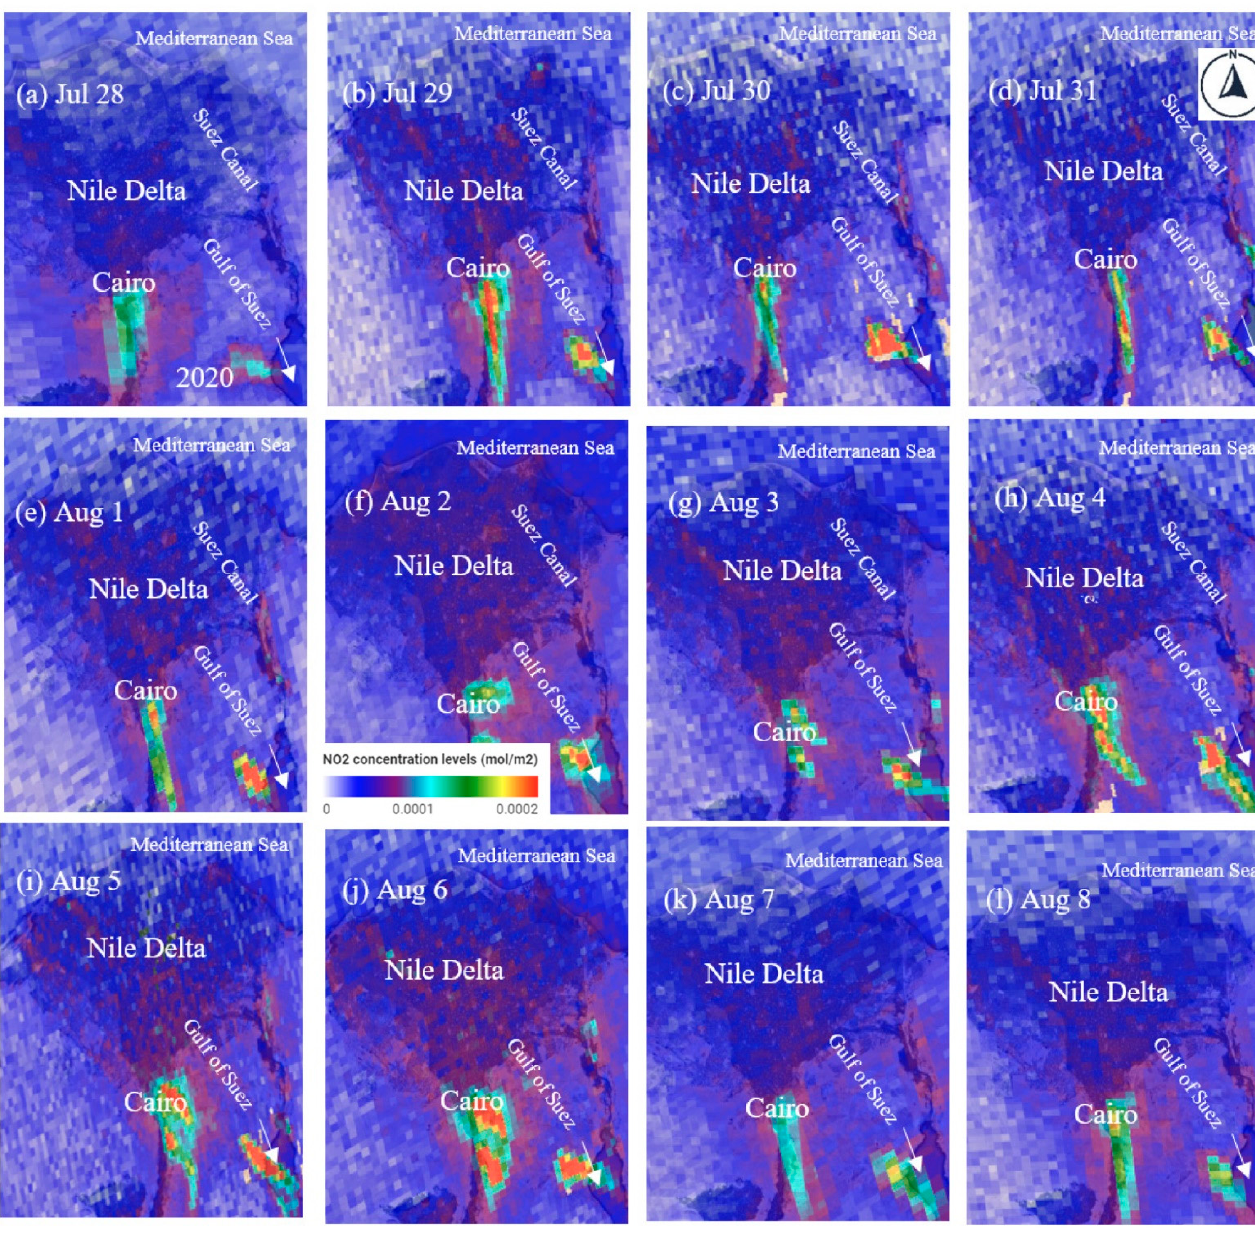
Figure 6. NO 2 concentrations over Cairo and the Gulf of Suez Egypt 28 July–11 August 2020.